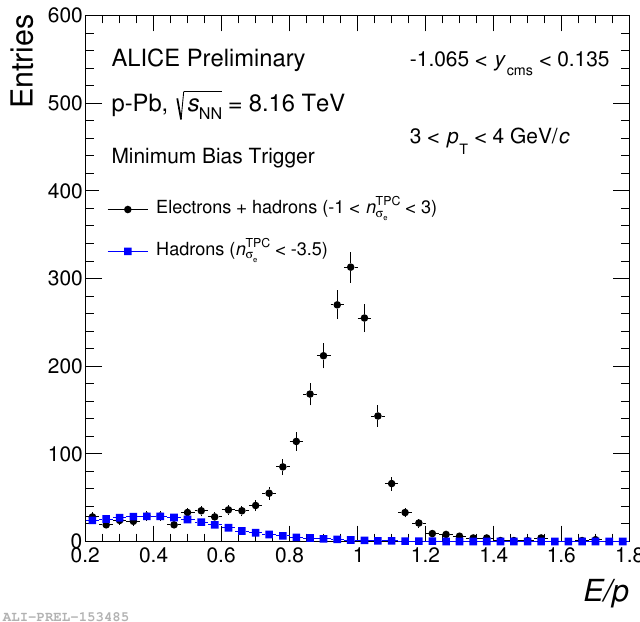
Figure 2. E / p distribution in 3 < p T < 4 GeV/ c in minimum-bias